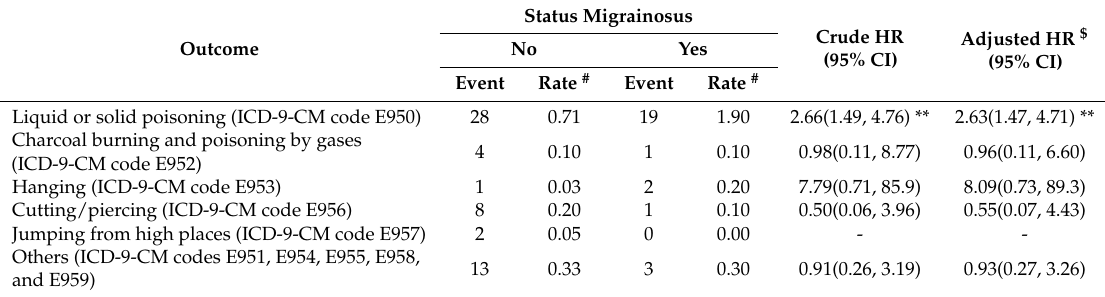
Table 5. Incidences and hazard ratios of different methods of suicide attempts between cohorts of status migrainosus and